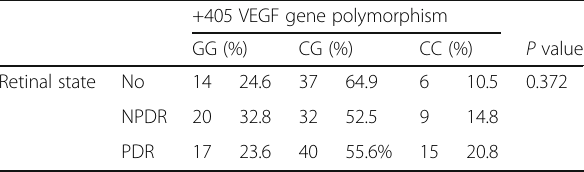
Table 6 Genotype frequency of +405 G/C VEGF polymorphism in patients with retinopathy phenotype (A – Table 5 Genotype frequency of +405 G/C VEGF polymorphism in patients related to severity (NPDR&PDR) of retinopathy +405 VEGF gene polymorphism